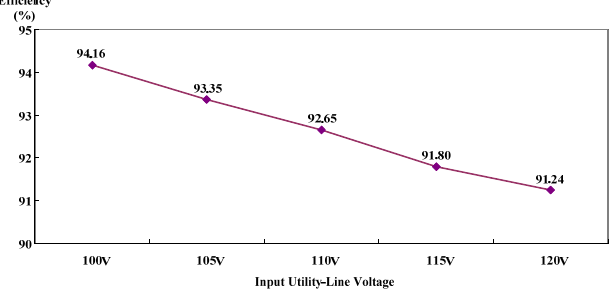
Figure 16. Measured efficiency of the presented LED tube lamp driver under different input utility ‐ line voltages.